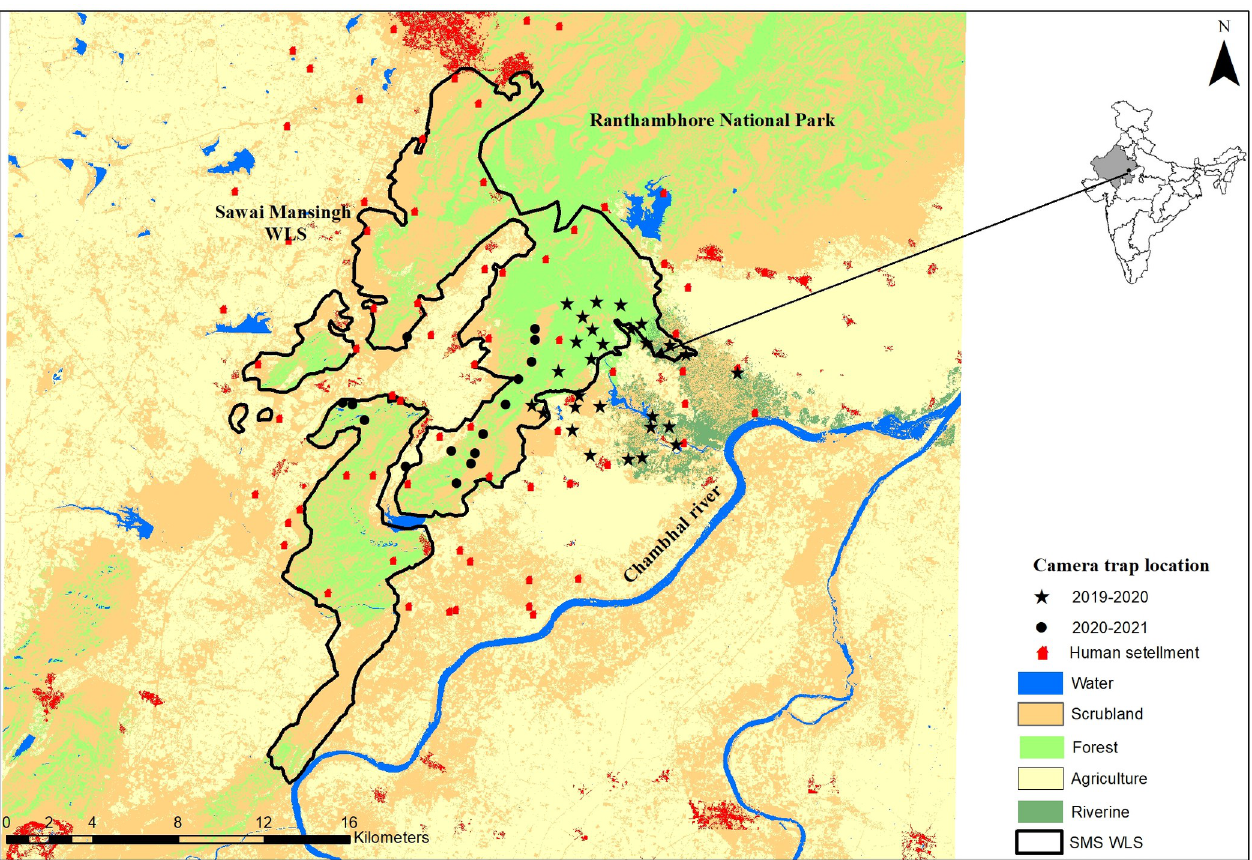
Fig 1. Location map of the study area and camera trap location in Sawai Mansingh Wildlife Sanctuary Rajasthan from November 2019 to March 2021.